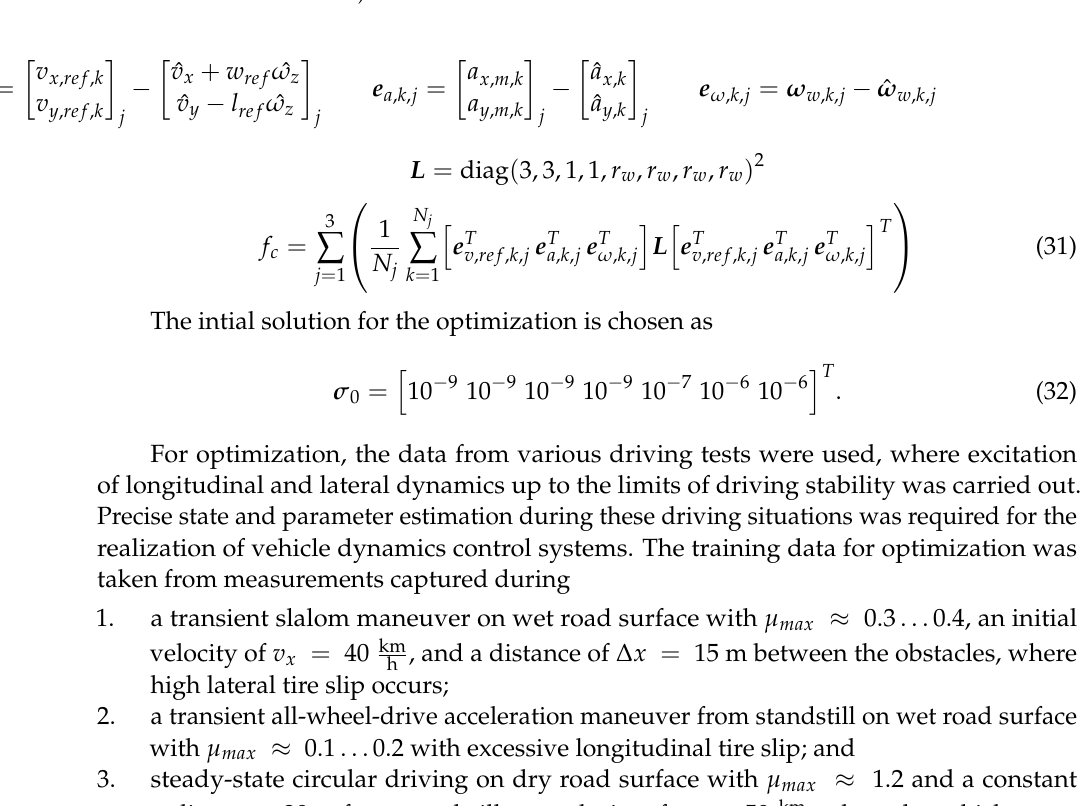
Figure 2. Experimental electric vehicle BugEE with four wheel hub motors on ( a ) a wet road surface and ( b ) a dry road surface. Maximum torque for each front motor is 115 Nm; maximum torque for each rear motor is 261